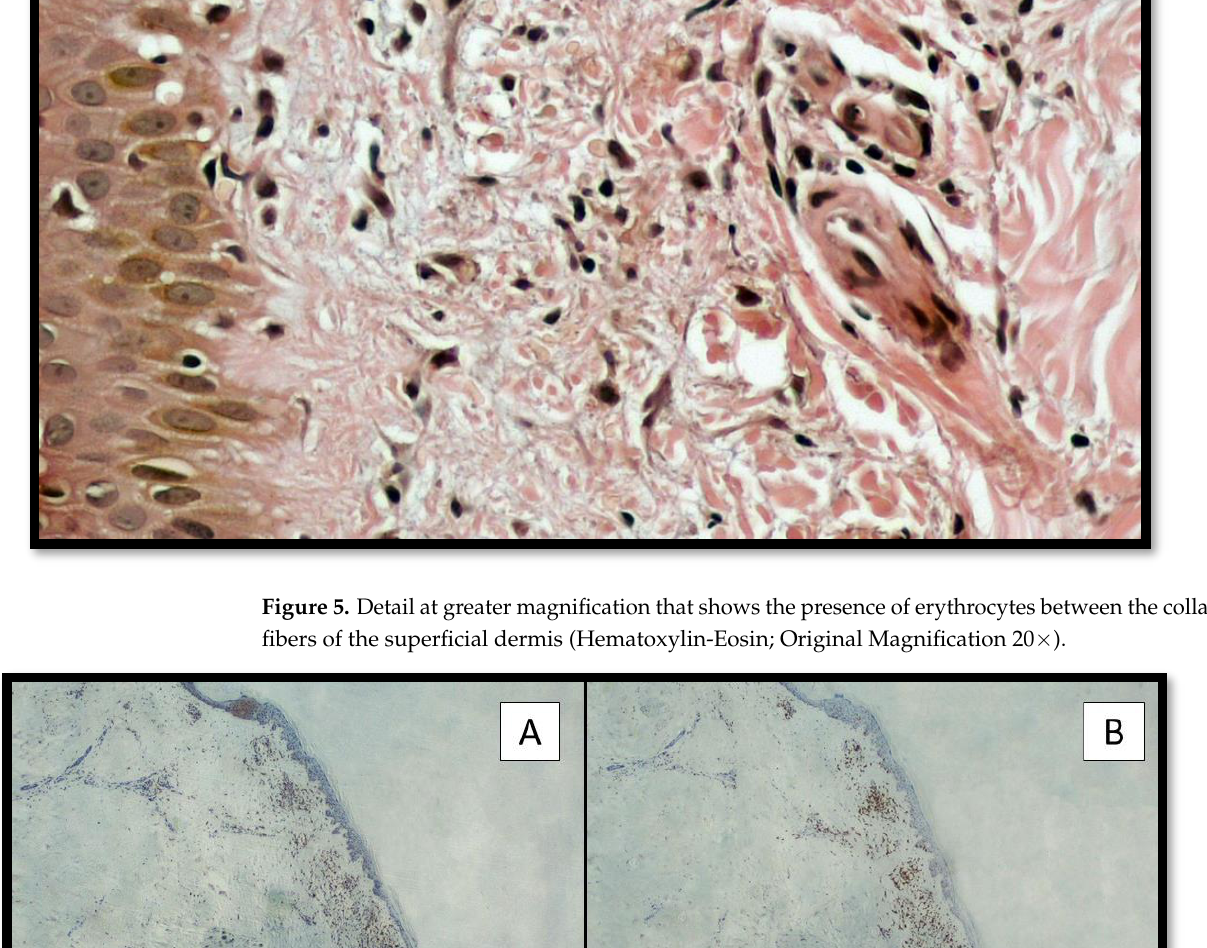
Figure 6. Immunostaining for CD4 ( A ) and CD8 ( B ) T-lymphocytes: note the similar quantity of T-cells and distribution at perivascular and peri-adnexal sites. (Immunohistochemistry; Original Magnification 4 ×).